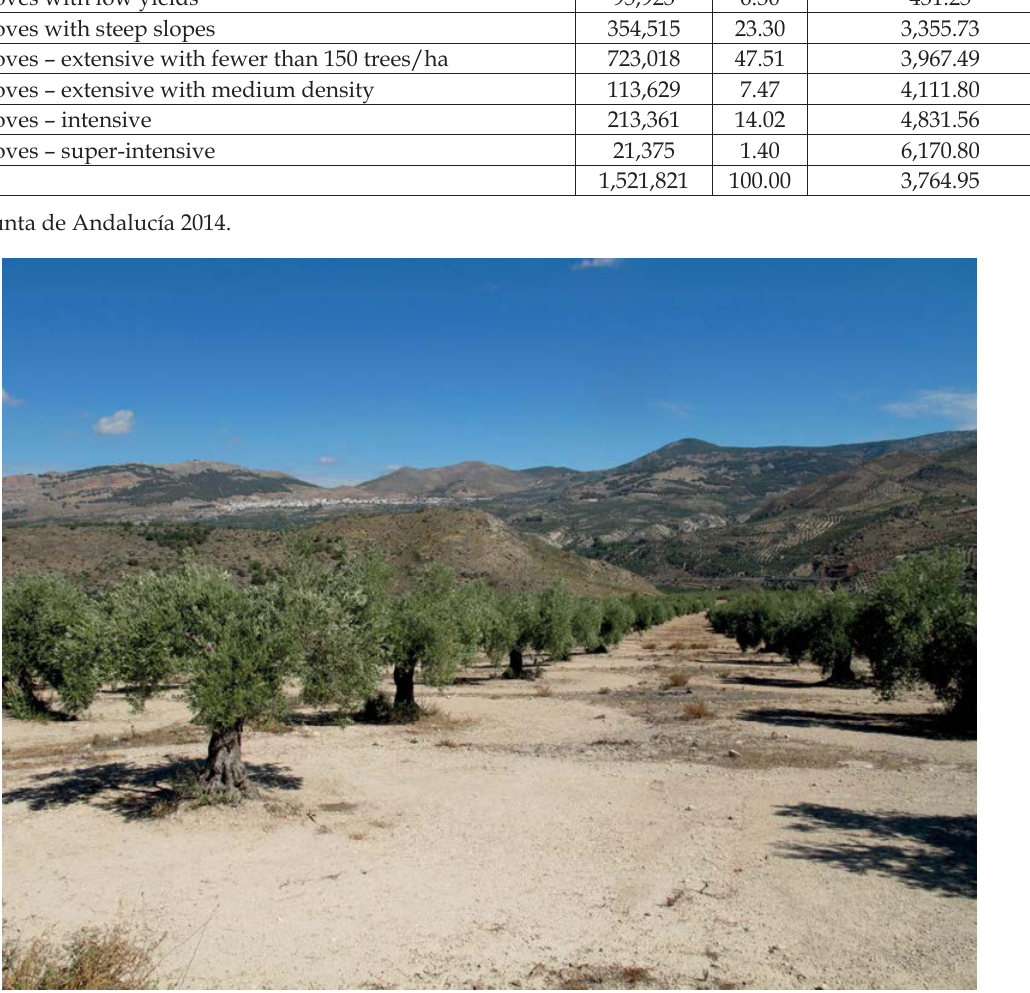
Photo 1. Marginal olive grove (photo: José D. Sánchez Martínez).